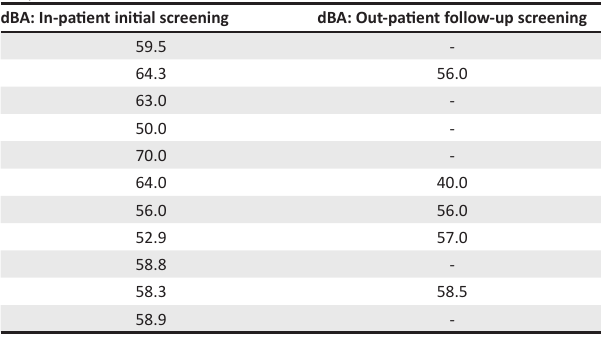
TABLE 4: Sound level recordings within the screening environments at the first